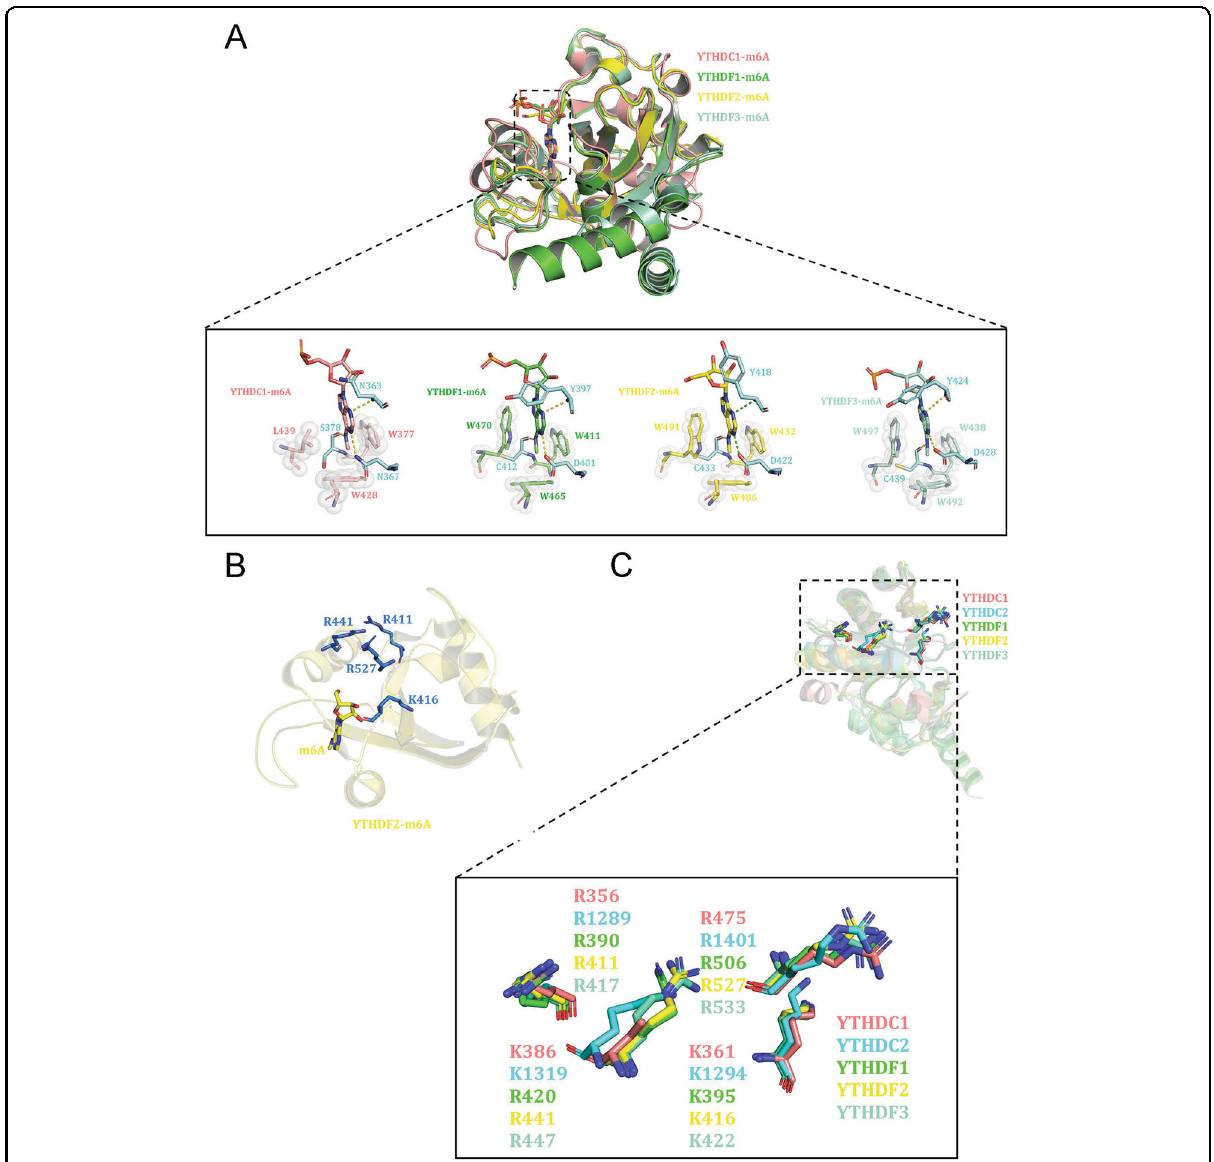
Fig. 3 The conserved aromatic residues and basic residues in the YTH domain are responsible for methylated adenosine (m6A) recognition and binding, respectively. A Superposition of the complex structures of the YTHDC1 YTH domain (YTH-YTHDC1)-m6A (pink), YTH- YTHDF1-m6A (green), YTH-YTHDF2-m6A (yellow), and YTH-YTHDF3-m6A (pale green), showing the conserved aromatic cage for speci fi c recognition of the methyl group of m6A. Both the residues in the aromatic cage of YTHDC1 and the 6-methylated adenine base (m6A) are shown in the model as pink sticks, and the counterparts in YTHDF1, YTHDF2, and YTHDF3 are shown in the model as green, yellow, and pale green sticks, respectively. In addition, the adenine base always forms three hydrogen bonds with adjacent residues (cyan sticks), which is essential for the binding between m6A and YTH domains. The hydrogen bonds are labeled with dashed lines. The corresponding PDB IDs are 4R3I, 4RCJ, 4RDN, and 6ZOT. B Four basic residues, R411, K416, R441, and R527, on the surface of the YTHDF2 YTH domain, are critical for binding to the RNA backbone. C Superposition of the YTH domains of YTHDC1 (pink cartoon), YTHDC2 (cyan cartoon), YTHDF1 (green cartoon), YTHDF2 (yellow cartoon), and YTHDF3 (pale green cartoon). The four basic residues are highly conserved in these human YTH proteins. The basic residues R411, K416, R441, and R527 in YTHDF2 and their corresponding residues in the YTH domains of YTHDC1, YTHDC2, YTHDF1, and YTHDF3 are shown as yellow, pink, cyan, green, and pale green